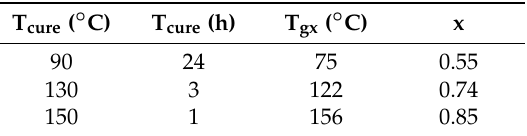
Table 2. Glass transition temperature and conversion of the neat system as a function of the cure temperature and duration, x values (at the end of each pre-curing step) are evaluated from the Di Benedetto curve of the CTT phase diagram.